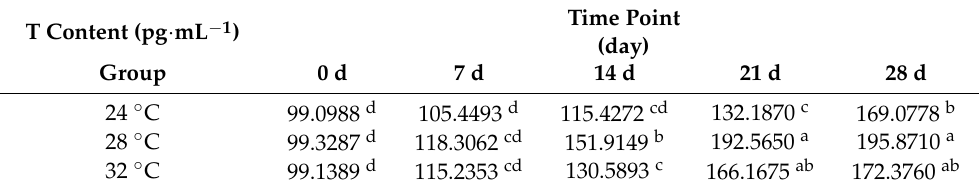
Table 5. Changes of serum T content in Nile tilapia serum after different temperature treatments. T Content (pg · mL − 1